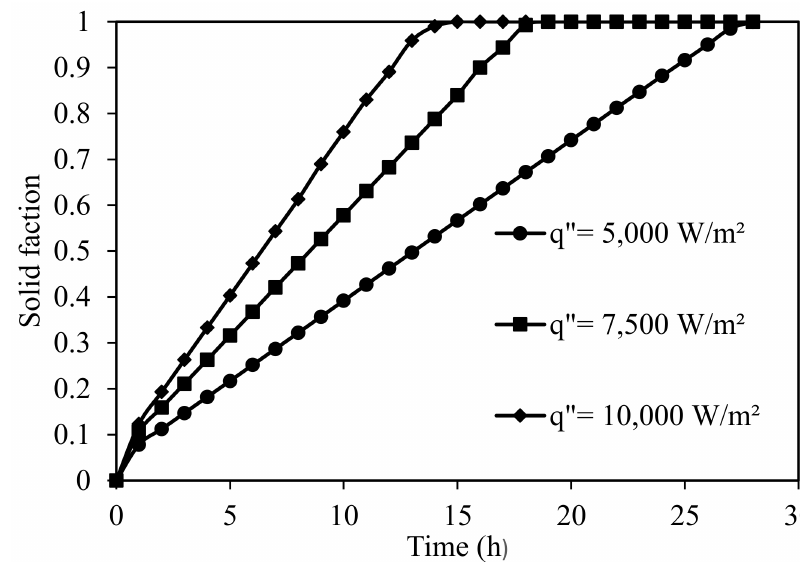
Figure 13. Influence of heat flux on discharge